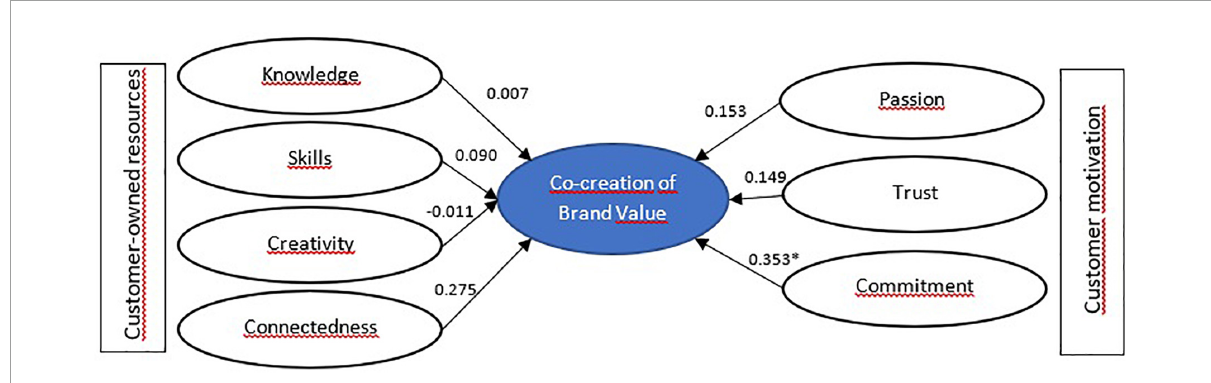
FIGURE2 Model estimation for detractor customers—Segment 1. ∗ p < 0.05.